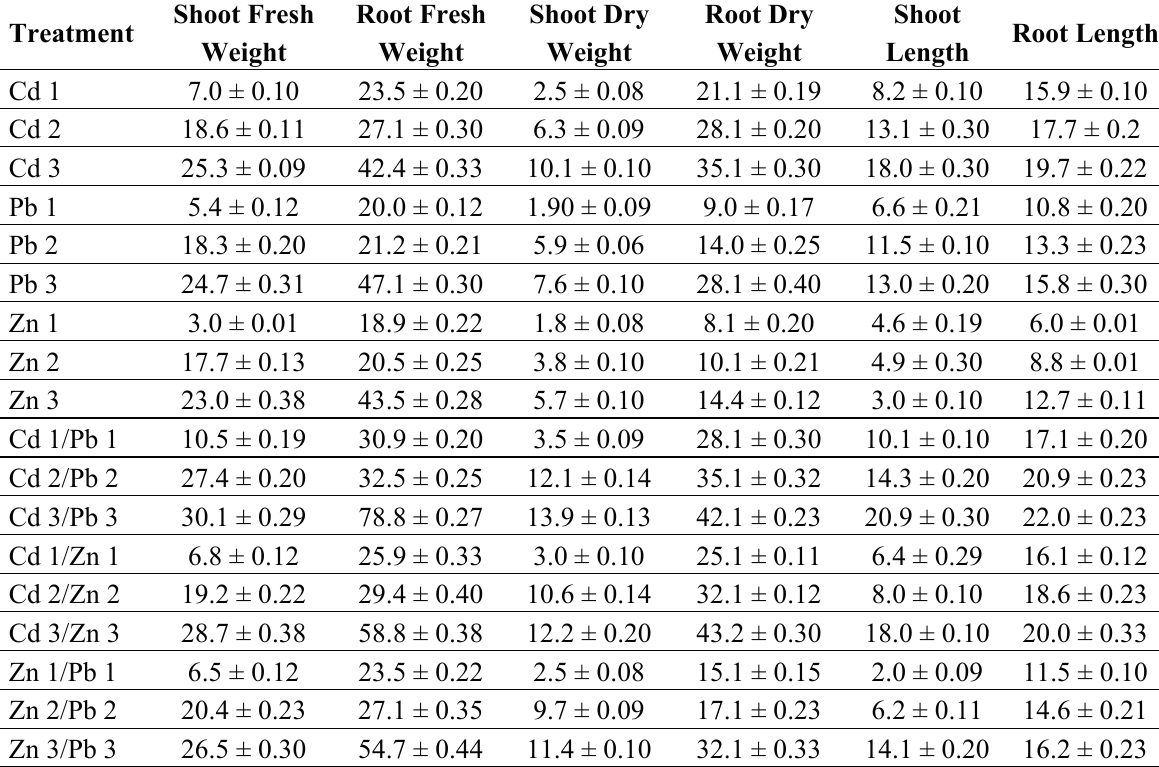
Table 2. Reduction (%) in growth parameters of Spinach ( Spinacia oleracea ) due to different heavy metal (cadmium (Cd), Pb (lead) and Zn (zinc)) treatments (in comparison to the